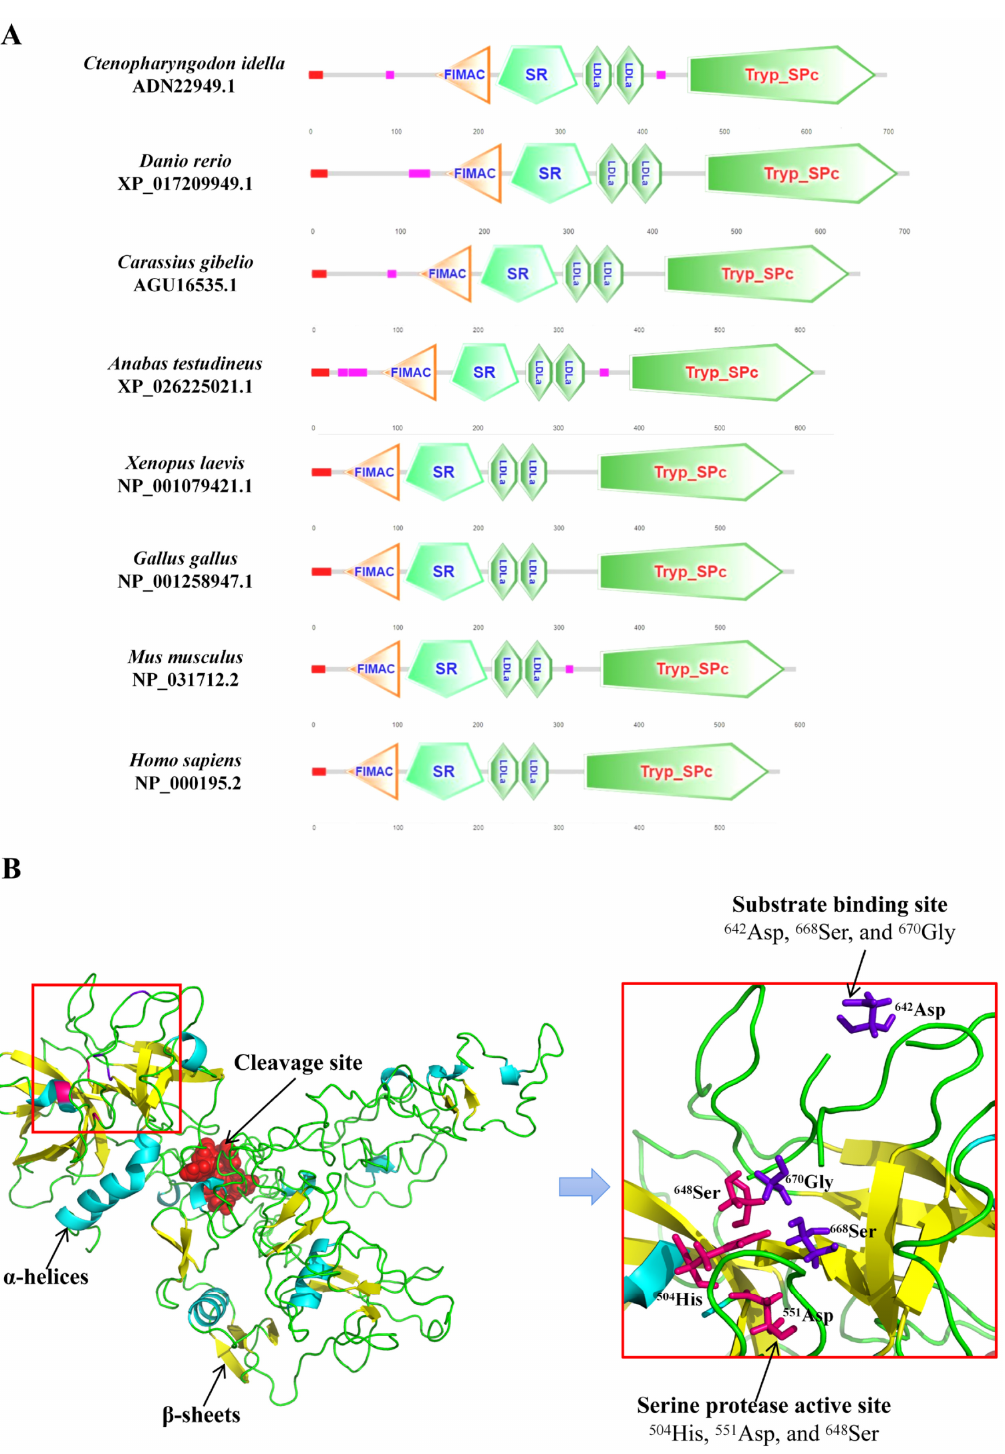
Figure 3. The predicted domain architecture and three-dimensional structure of CiCFI. ( A ) The predicted domain architectures of CFIs from C. idella , D. rerio , C. gibelio , A. testudineus , X. laevis , G. gallus , M. musculus , and H. sapiens were compared. FIMAC, SR, LDLa, and Tryp_SPc represent the abbreviations for factor I membrane attack complex, Scavenger receptor Cys-rich, low-density lipoprotein receptor domain class A, and trypsin-like serine protease, respectively. The scale on the bottom indicates the amino acid number. ( B ) In the predicted three-dimensional structure of CiCFI, the cleavage site is marked in red spheres, serine protease active site is colored in magenta, and substrate binding site is colored in